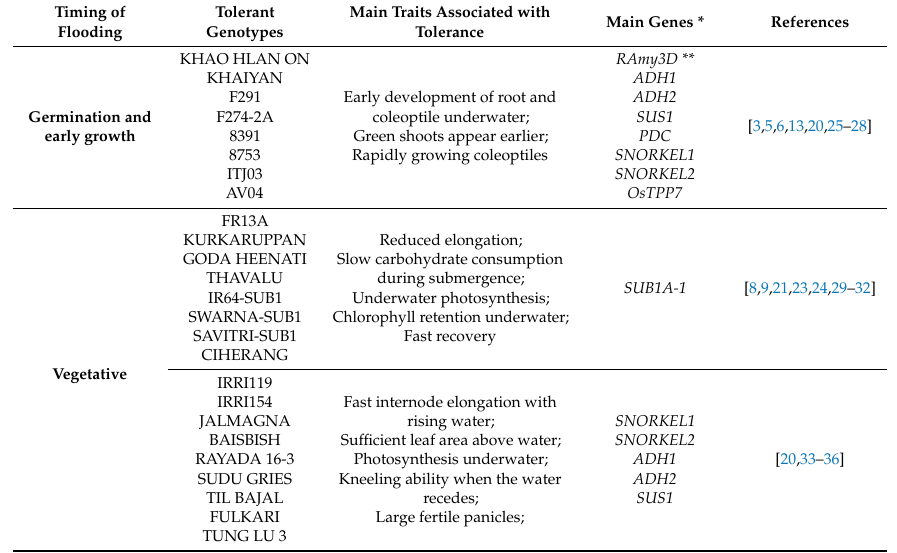
Table 1. Rice genotypes identified with flooding tolerance in the di ff erent development